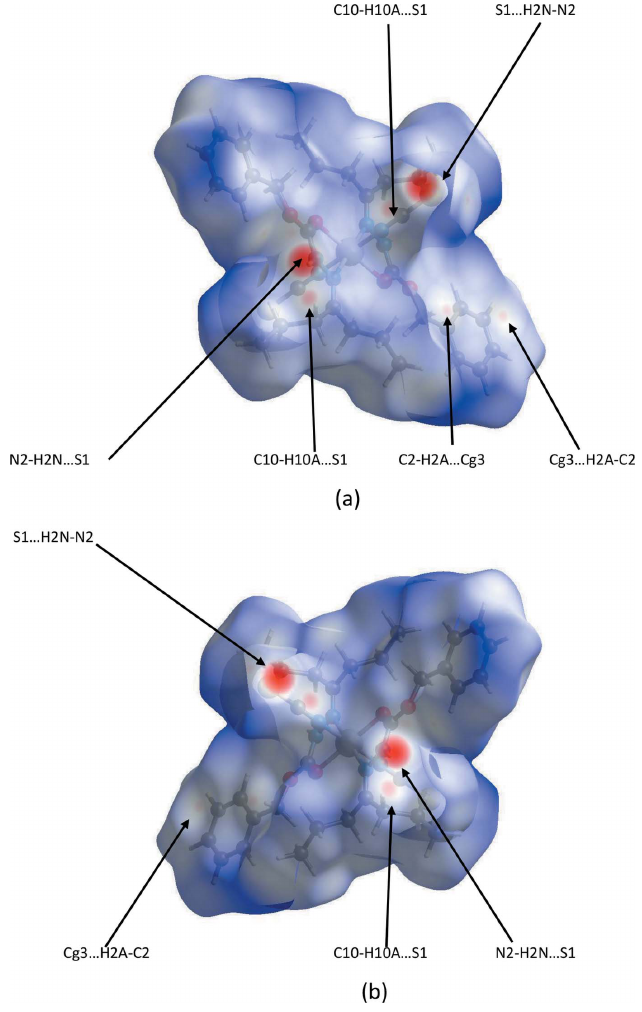
Figure 6 Hirshfeld surfaces for opposite faces ( a ) and ( b ) of 1 mapped over d norm in the range (cid:5) 0.3928 to 2.1718 a.u. Cg 3 is the centroid of the C3–C8 phenyl ring.